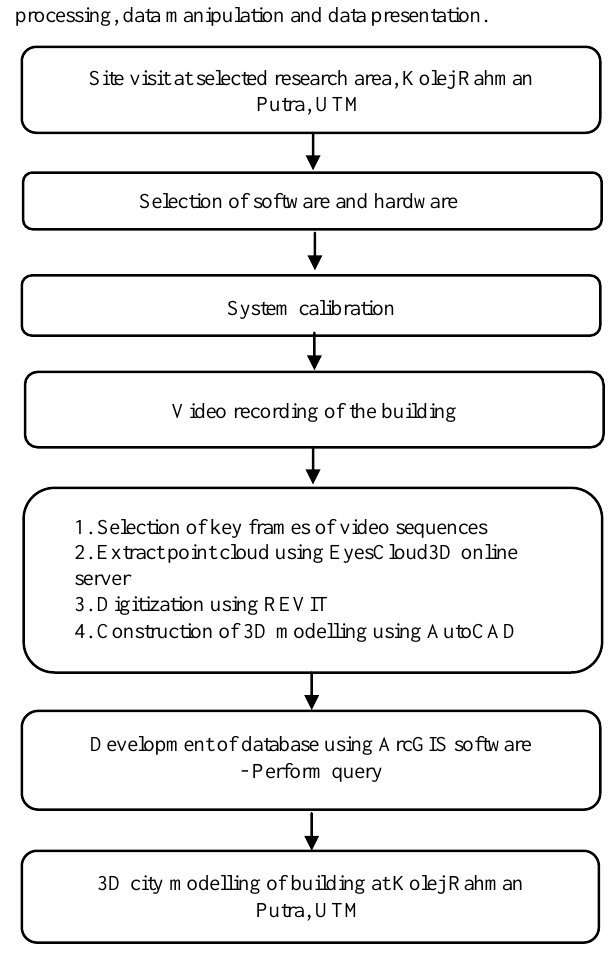
Figure 3 Flow chart of